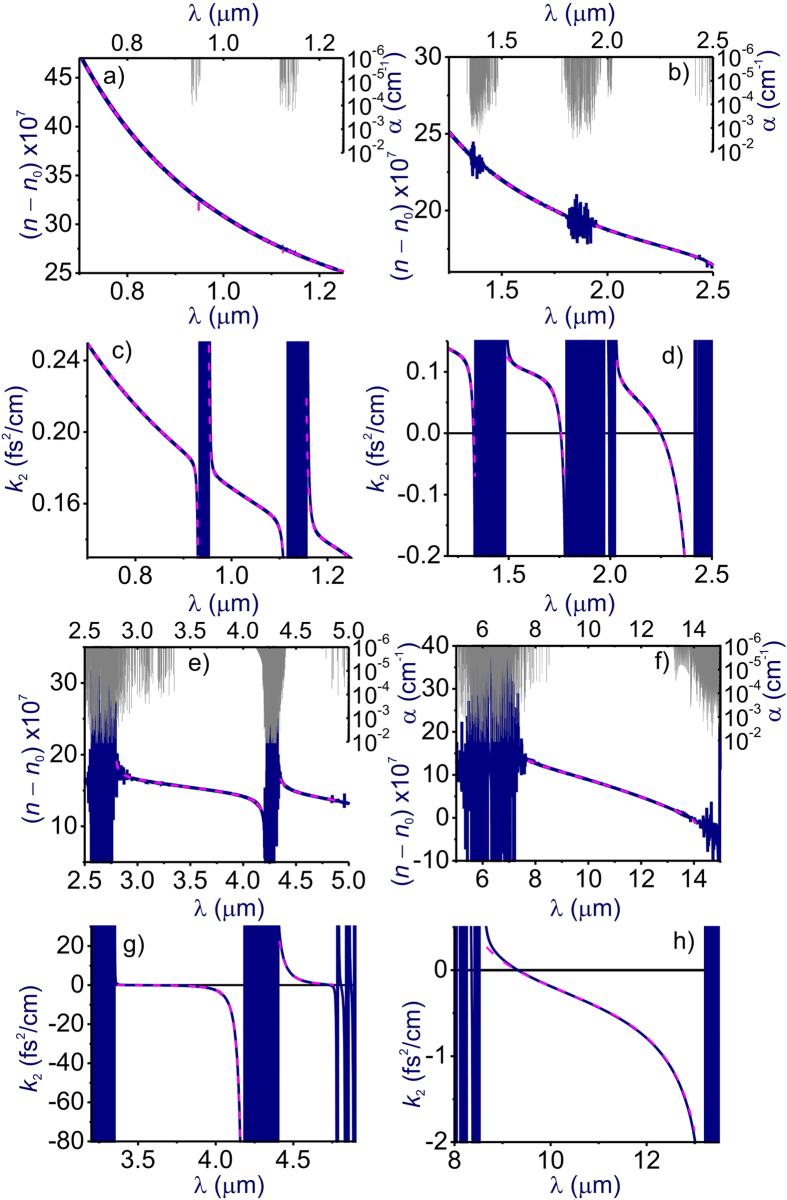
The same as in Fig. 1 for NH2O = 2.8305 ∙ 1017 cm−3 (40% humidity).